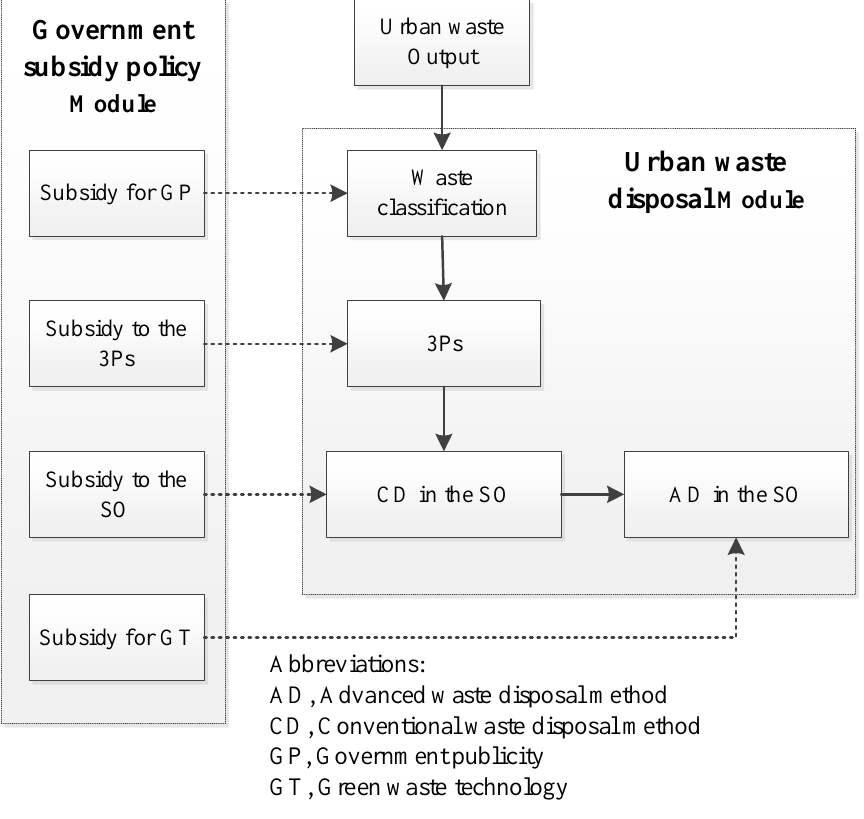
Figure 1. The model framework.